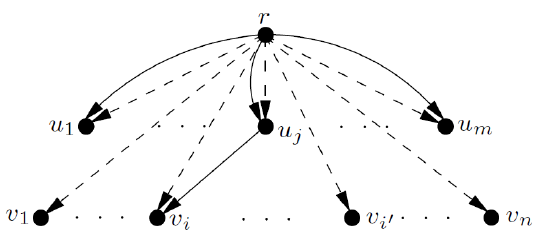
Figure 5. The reduction of Theorem 5. Dashed edges are fixed-cost edges, while the other edges are owned by the leader. In this example, o i is in S j , but o i (cid:48) is